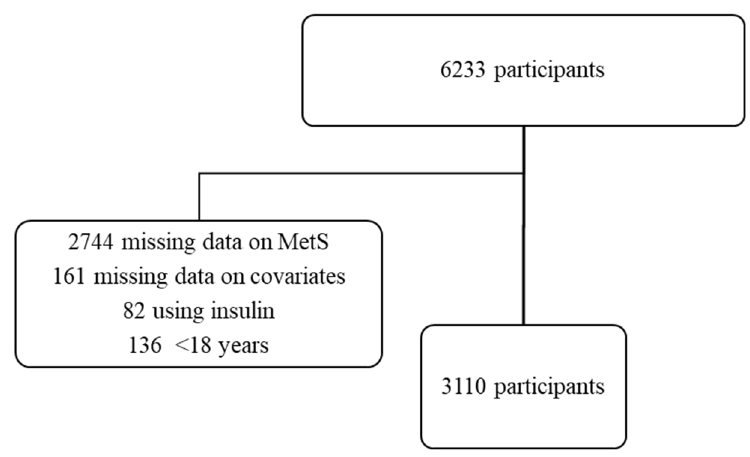
Figure 1. Flowchart of participants in the 2016–2017 Chilean National Health Survey.